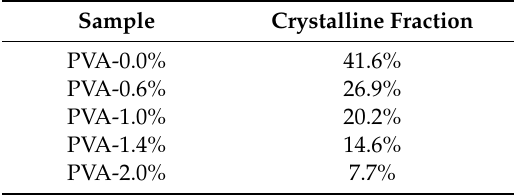
Table 1. Crystalline fraction of PVA samples calculated from the XRD